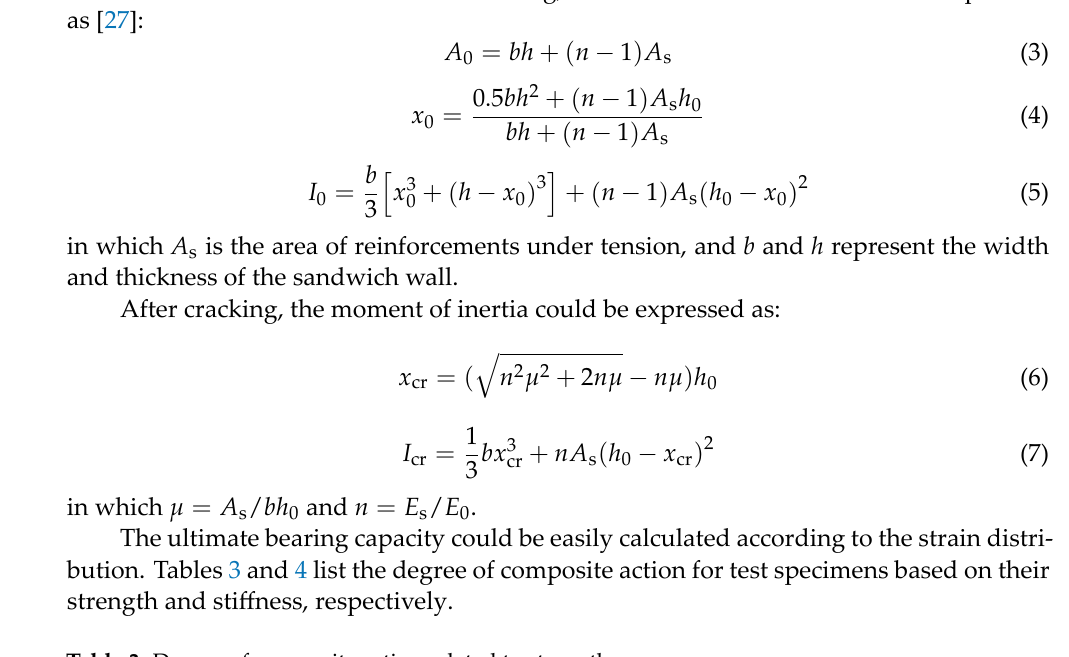
Table 3. Degree of composite action related to strength.